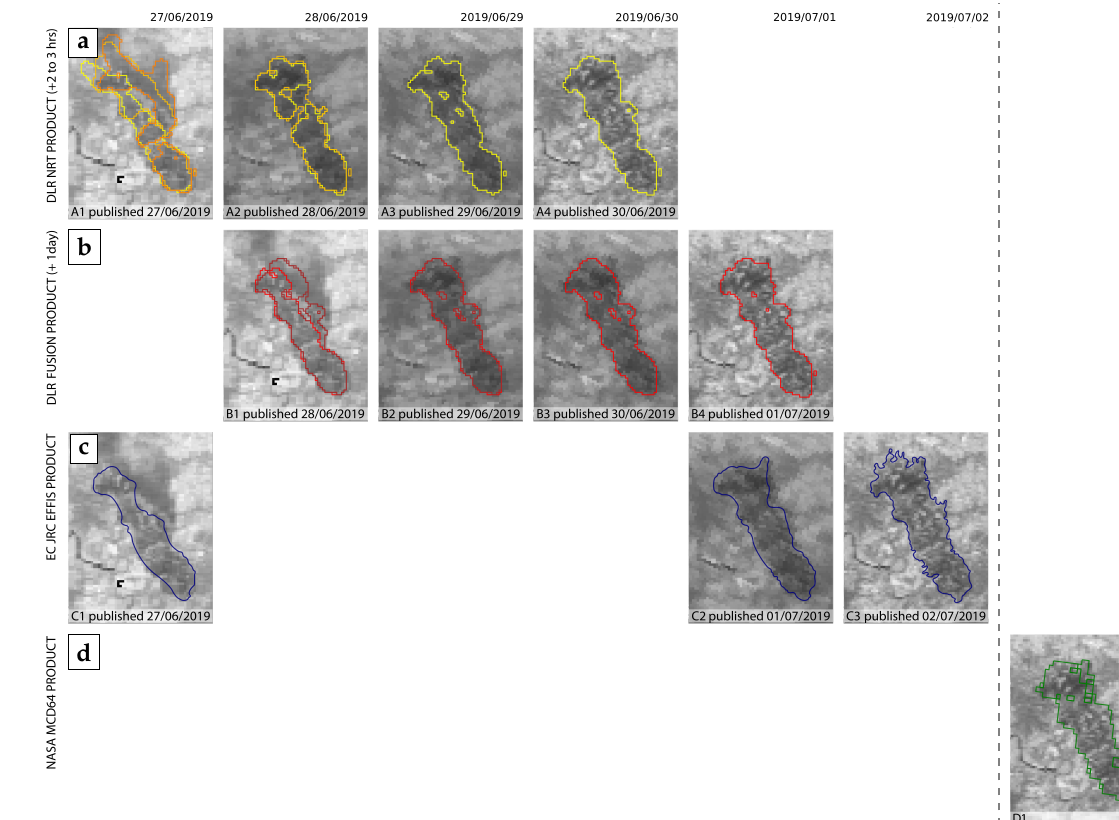
Figure 5. Inter-comparison of derived results and reference datasets, visualized in the order of the respective release date. Backgrounds: NIR channel of AQUA/TERRA Moderate-resolution Imaging Spectroradiometer (MODIS) post scenes in close temporal proximity to the detection. ( a ) Results of German Aerospace Center (DLR) NRT mode. ( b ) Results of DLR fusion mode. ( c ) Joint Research Center of the European Commission (JRC) European Forest Fire Information System (EFFIS) Burnt Area (BA) reference data. ( d ) National Aeronautics and Space Administration (NASA) MCD64A1 reference